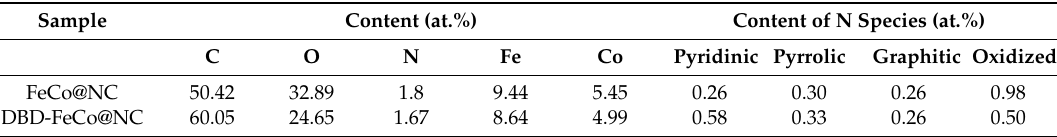
Table 1. Atomic content of FeCo@NC and